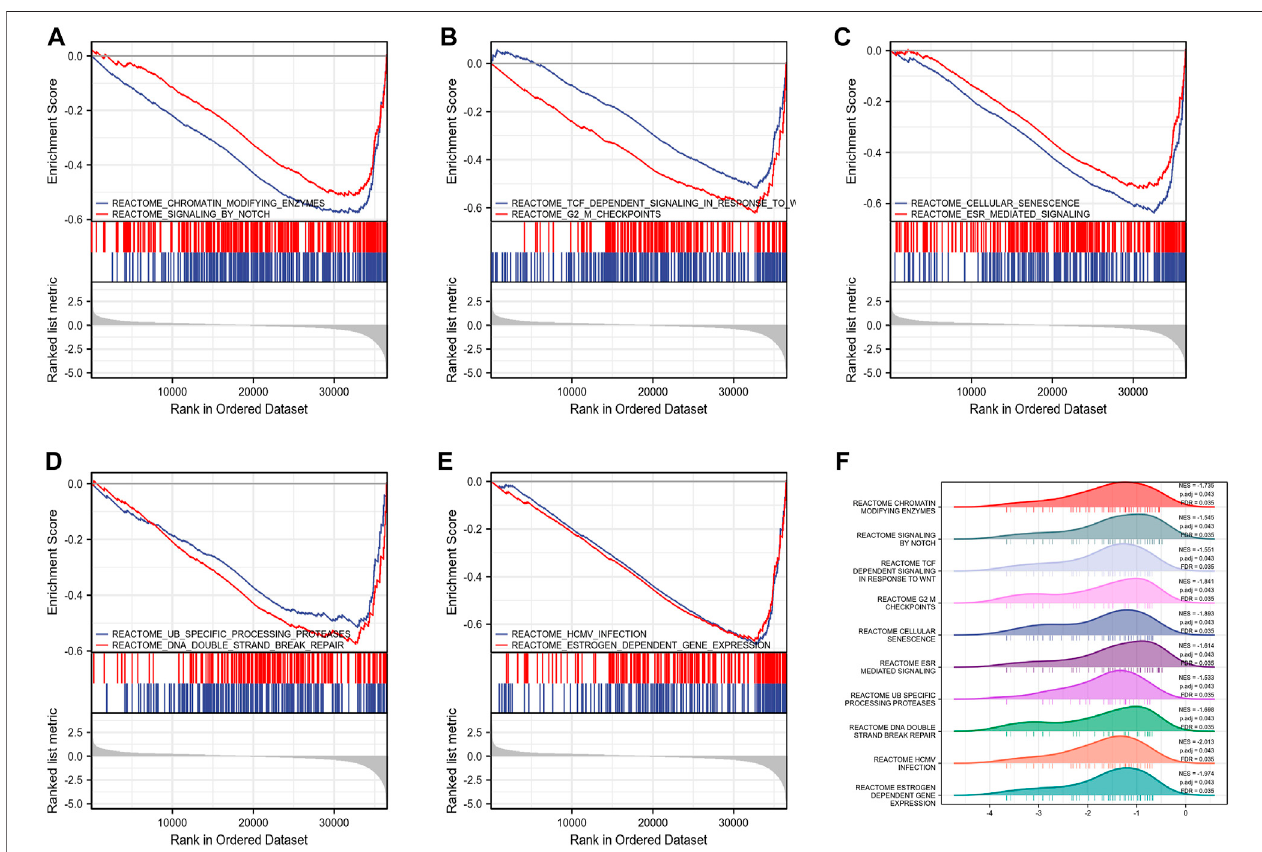
FIGURE 8 | Gene set enrichment analysis. (A – E) Top 10 items of GSEA. (F) Ridge plot of GSEA with NES, P. adj,